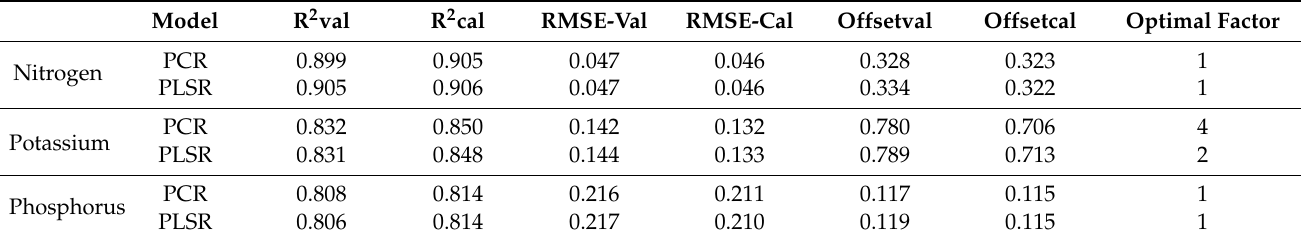
Figure 6. Cluster analysis dendrogram responds to different levels of urea fertilizer applied to cucumber plants. Table 3. PLSR and PCR model analysis results for chemical fertilizer residues in